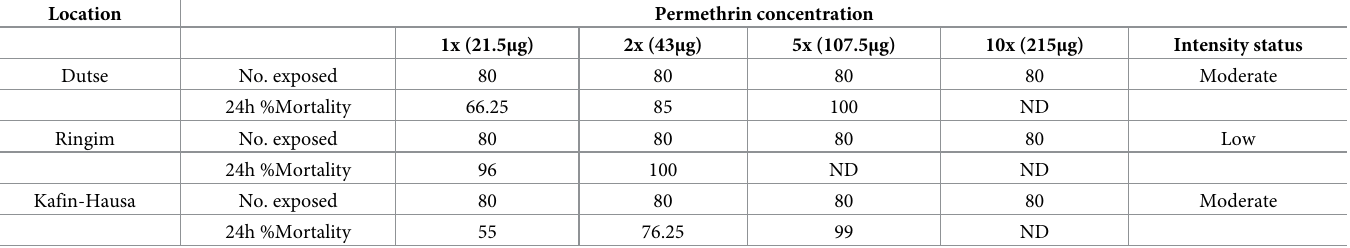
98%–100% mortality indicates susceptibility; 80%–97% mortality suggests the possibility of resistance; mortality < 80% suggests resistance. ND = Not done (This applies